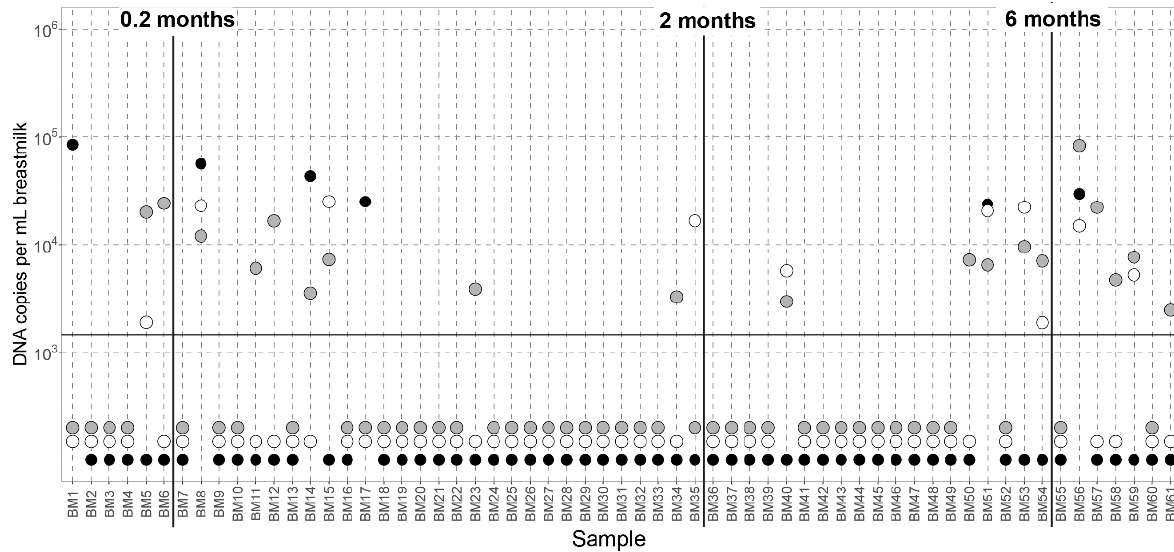
Figure 2. Anellovirus concentration in breast milk. All samples are arranged in the order of children’s age at the moment of the breast milk collection. The samples under the horizontal line were either negative for the viruses, or samples contained concentrations below the cutoff. Filled black dots represent alphatorqueviruses, white dots betatorqueviruses, and gray dots gamma- or betatorqueviruses. In the breast milk samples, the mean DNA concentration measured in the Alpha- torquevirus qPCR showed higher values than the other qPCRs, but this difference was not statistically significant (Wilcoxon test, p > 0.05). Of note are the high AV DNA concentrations measured in the breast milk samples obtained from three HIV-1 positive women: samples BM66, BM70, and BM71 contained >10 6 AV DNA copies per mL of milk